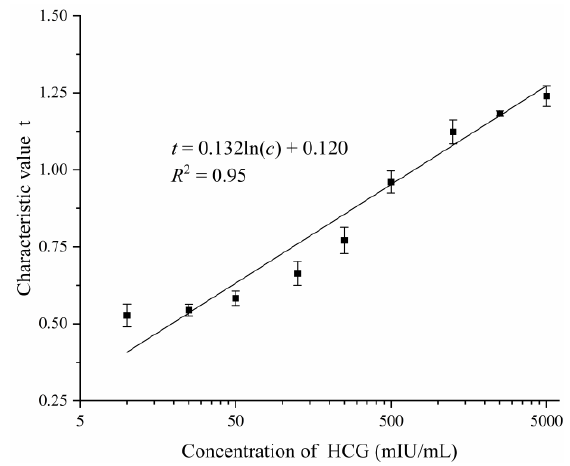
Figure 6. Relationship between the concentration of HCG and characteristic value.